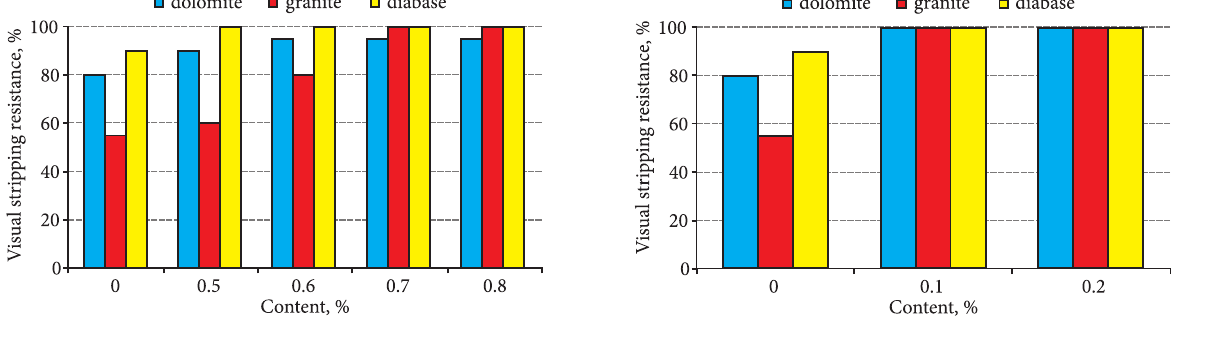
Fig. 6. Stripping resistance with bitumen B70/100 Nynas form Estonia containing polyaminoamide based liquid